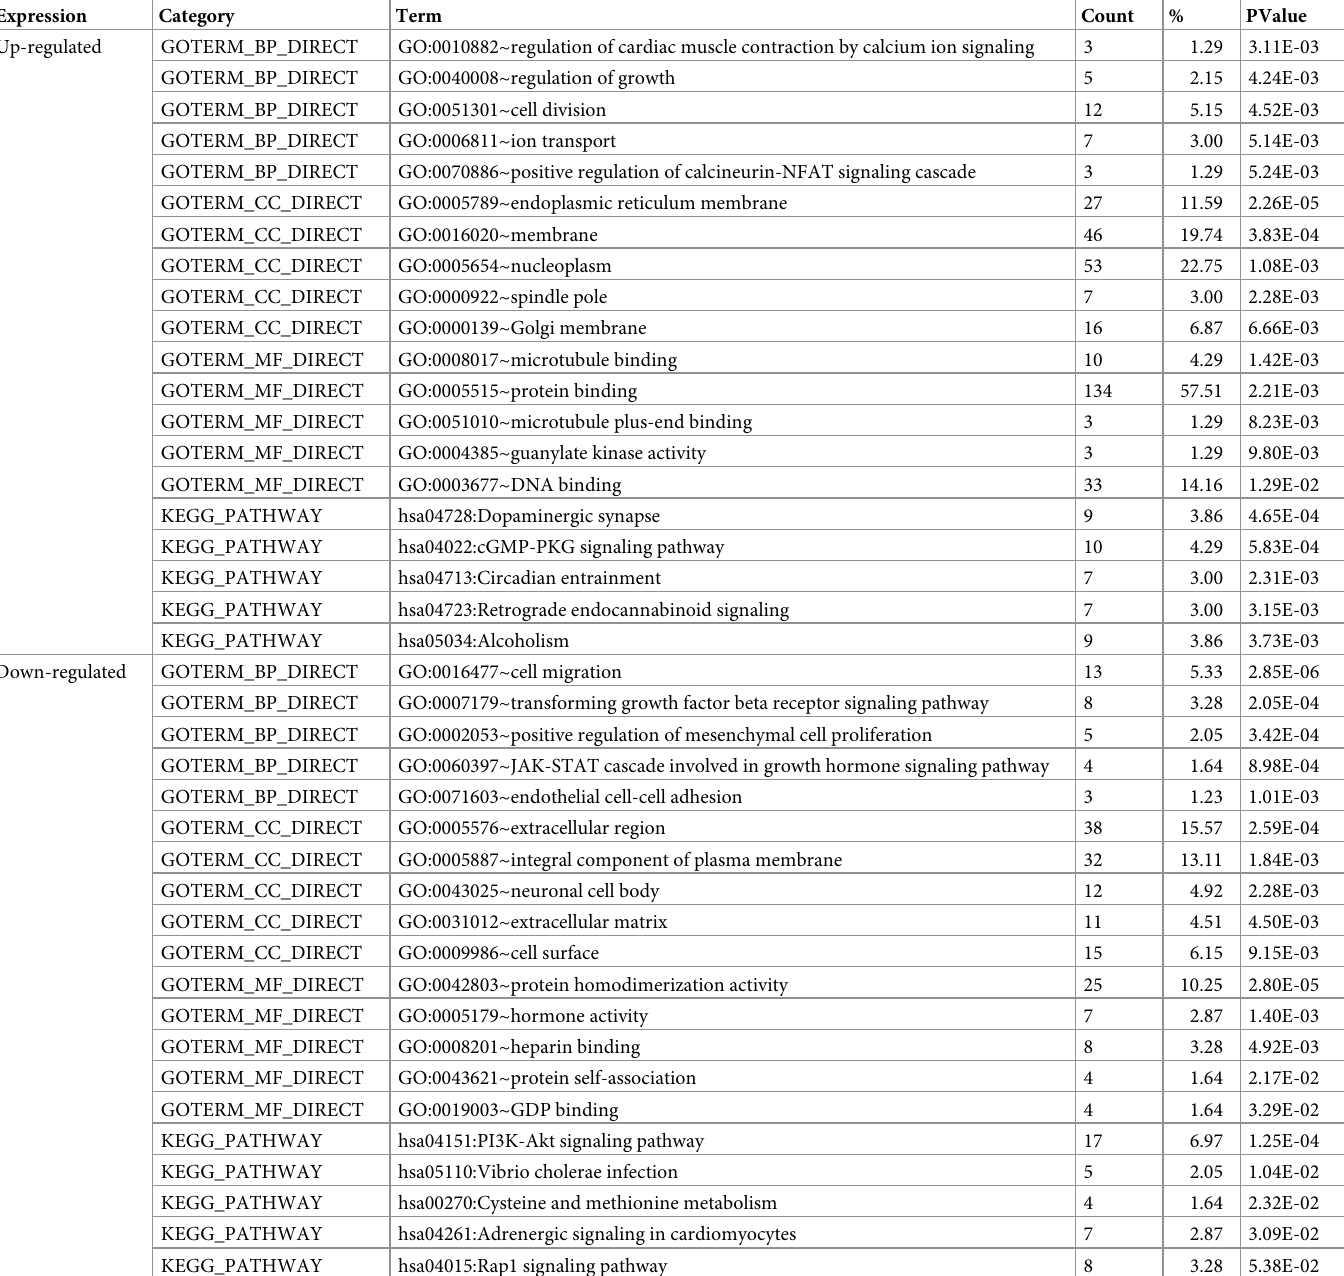
Table 1. Functional and pathway enrichment analysis of up-regulated and down-regulated genes in NFPAs. Expression